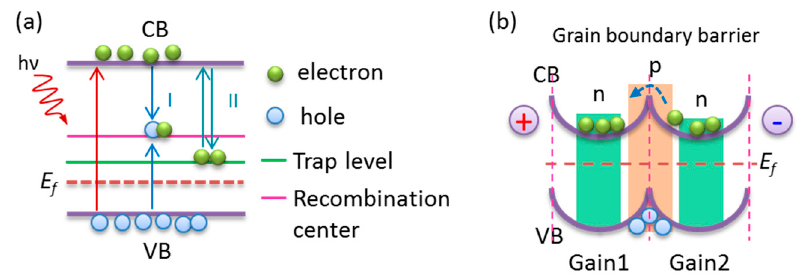
Figure 2. The schematics of ( a ) the minority carrier trap and ( b ) the grain boundary barrier models.